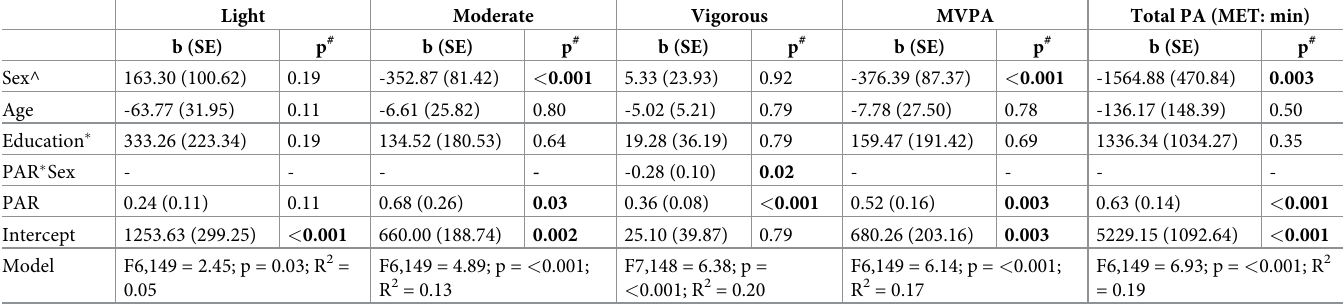
Table 2. Summary of multivariate models examining the association between physical activity as measured by the PAR questionnaire and the SWA. Light